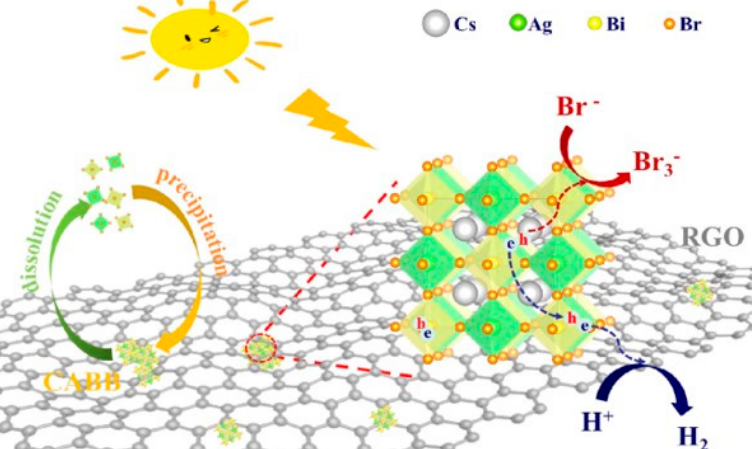
Figure 8. Schematic mechanism of H 2 evolution in aqueous HBr solution by Cs 2 AgBiBr 6 (CABB)/RGO composite under visible-light irradiation. Reproduced from [32], with permission from Elsevier, 2020. Table 1. Summary of the photocatalytic metal halide perovskite (MHP) systems discussed in this review. Photocatalyst